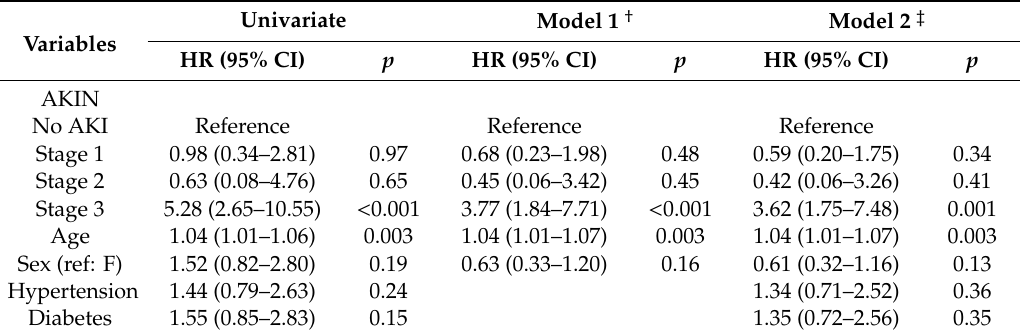
Table 4. E ff ect of AKI on mortality among all hospitalized COVID-19 patients.